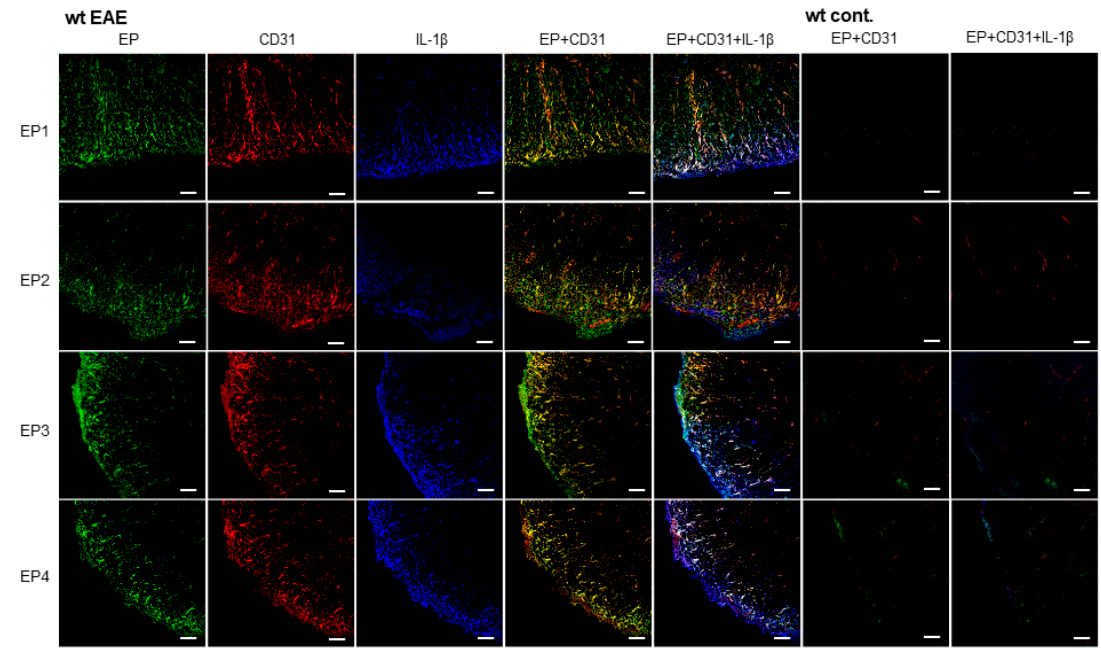
Figure 5. Expression of E-prostanoid (EP) receptors and interleukin-1 β (IL-1 β ) in CD31-positive (CD31 + ) endothelial cells (ECs) in spinal cords in wild-type (wt) mice. Immunohistochemical images showing EP1–4 (green), CD31 (red), and IL-1 β (blue) in the inflammatory region of the spinal cords of experimental autoimmune encephalomyelitis (EAE) wt mice (wt EAE) and in the naïve spinal cords in wt control mice (wt cont.). Scale bars are 20 μ m (for all images); wt, wild-type; EAE, EAE mice; cont., naïve mice.